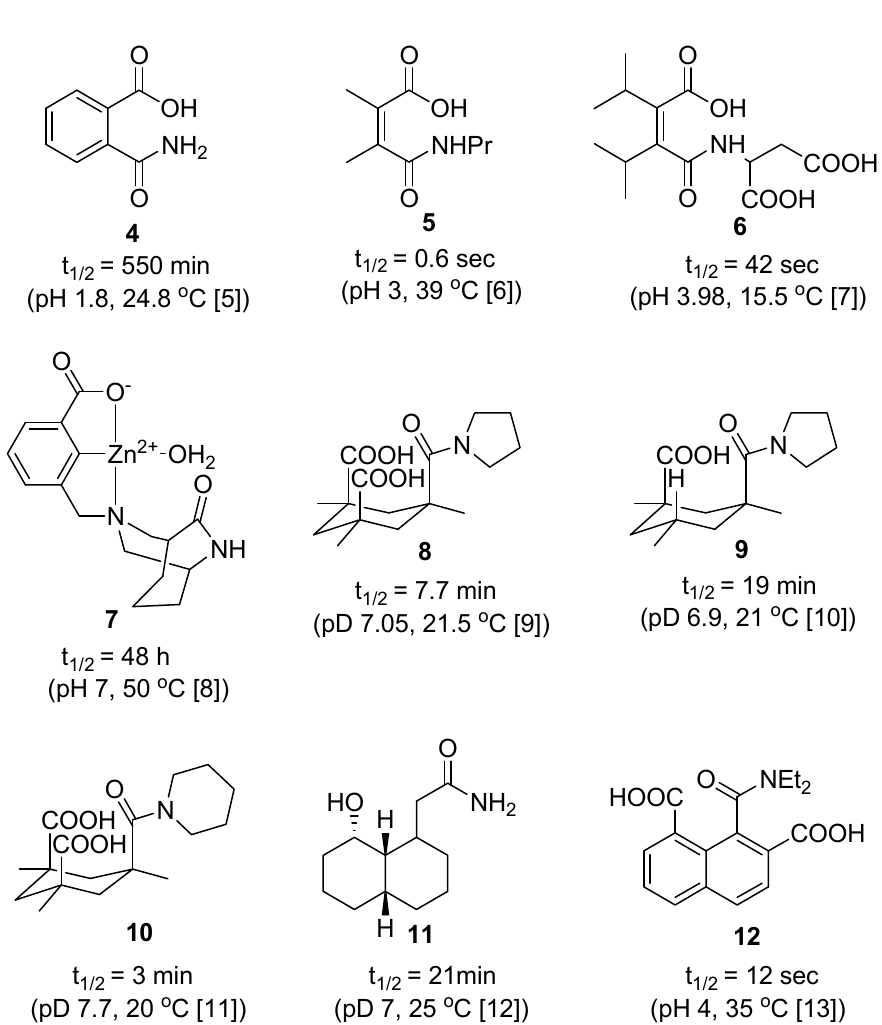
Figure 1. Selected compounds reported to undergo unusually fast amide bond hydrolysis in buffered water under mild conditions (indicated in brackets). Values of the half-life, calculated using the measured pseudo-first order rate constants k obs are listed for each compound.